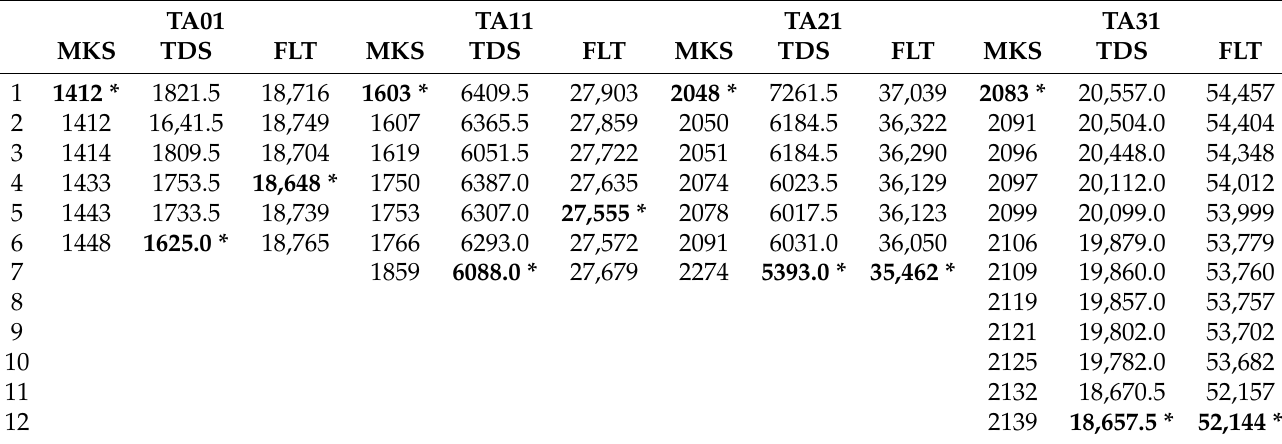
Table A6. Non-dominated front obtained by CMOSA for the JSSP instances proposed by